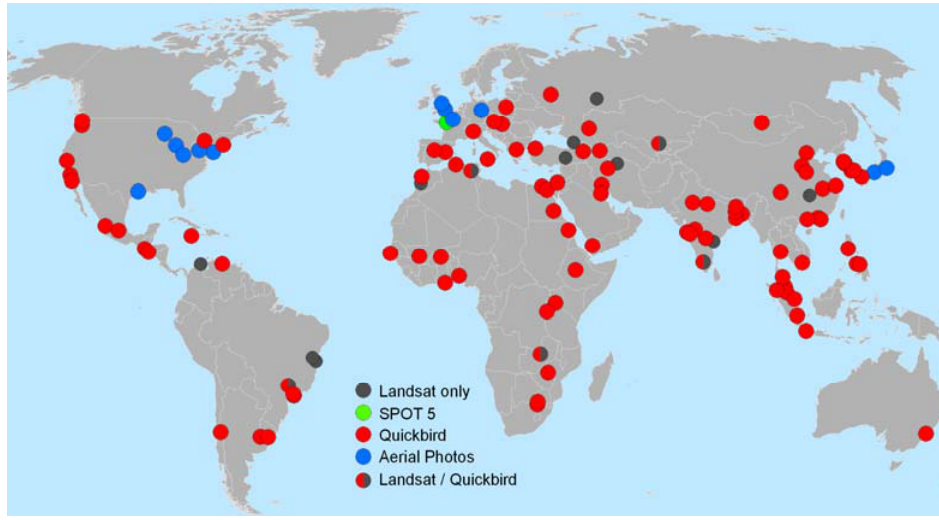
Figure 2. The 120-city global urban sample from Angel et al . [16]. Colored circles mark cities where high-resolution Google Earth imagery was available (109 cities) and gray circles mark cities where only Landsat GeoCover base imagery was available (11